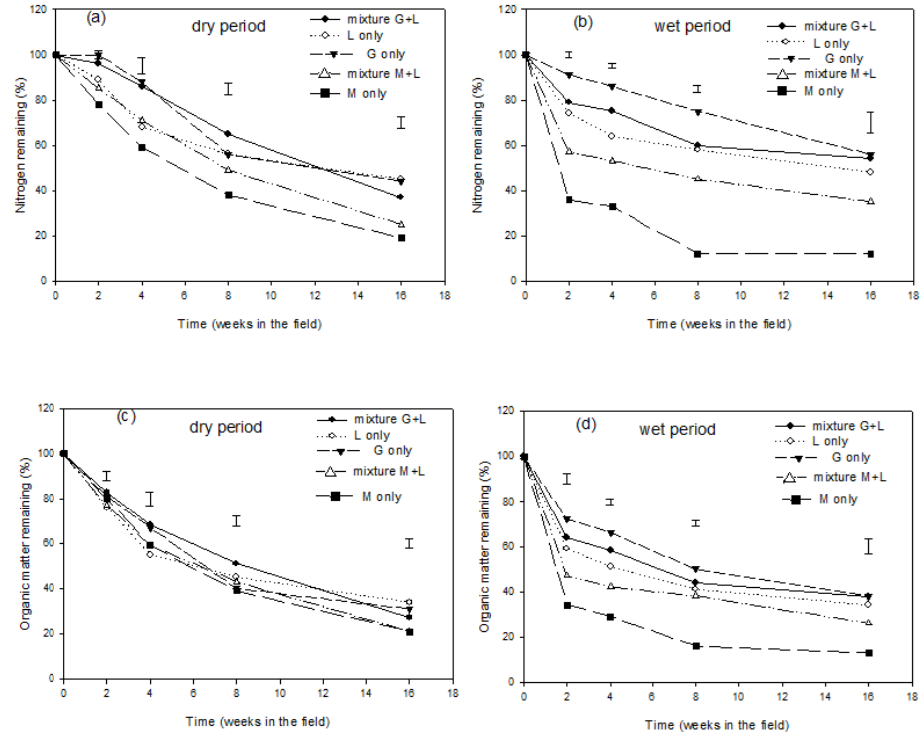
Figure 3. Percentage of N (( a ) and ( b ) during dry and wet season, respectively) and OM (( c ) and ( d ) during dry and wet season, respectively) remaining in mixtures and pure-residue litter bags from different tree species. Symbol corresponds to the mean values. Vertical bars are standard errors between means (SED).